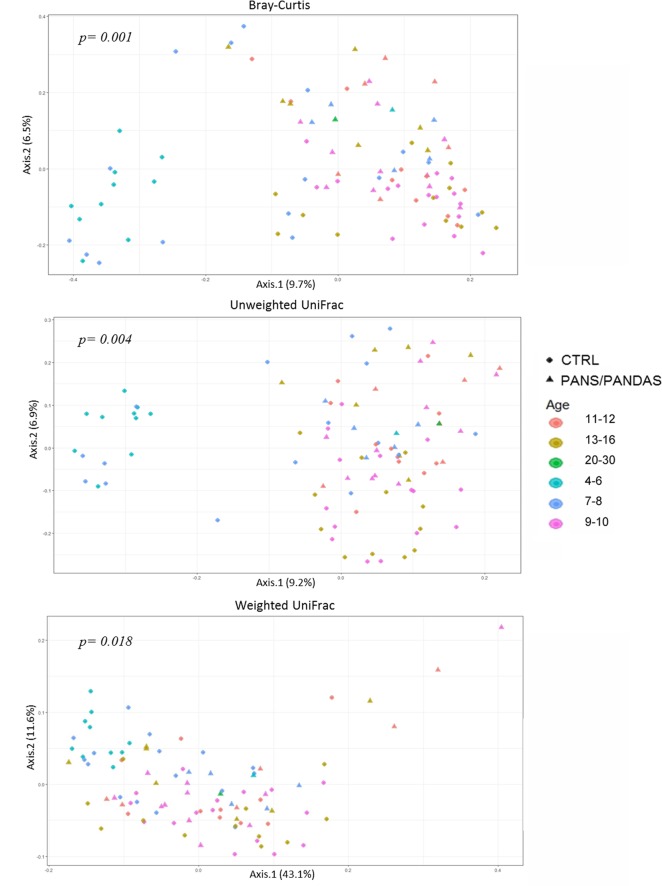
Principal coordinate analysis plot of PANS/PANDAS and CTRL groups. The plots show the first two principal coordinates (axes) for principal coordinates analysis (PCoA) using Bray–Curtis (A), unweighted UniFrac (B), and weighted UniFrac (C) algorithms. The resulting p-values for PERMANOVA analyses are reported in the figures.